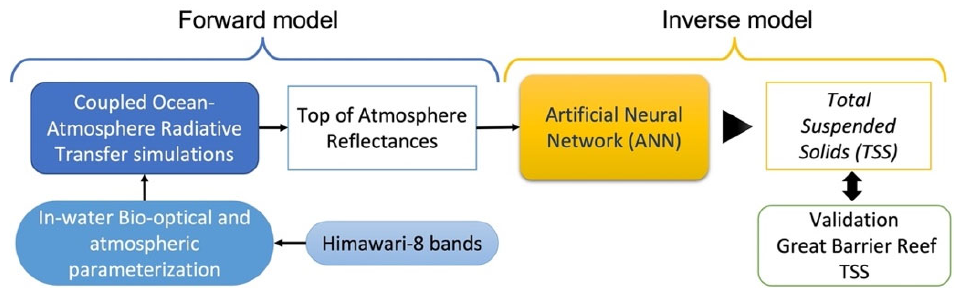
Figure 2. Flow diagram of the model ‐ based ocean colour algorithm developed for Himawari ‐ 8.